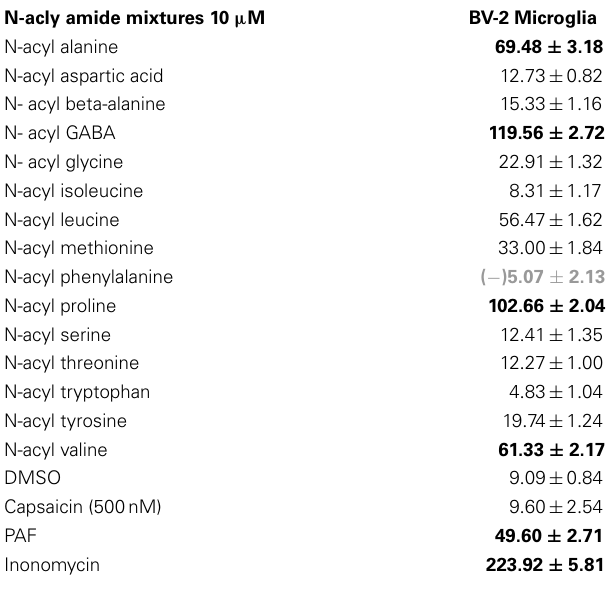
Table 4 | Agonist effects of N -acyl amide mixtures on calcium mobilization in BV-2